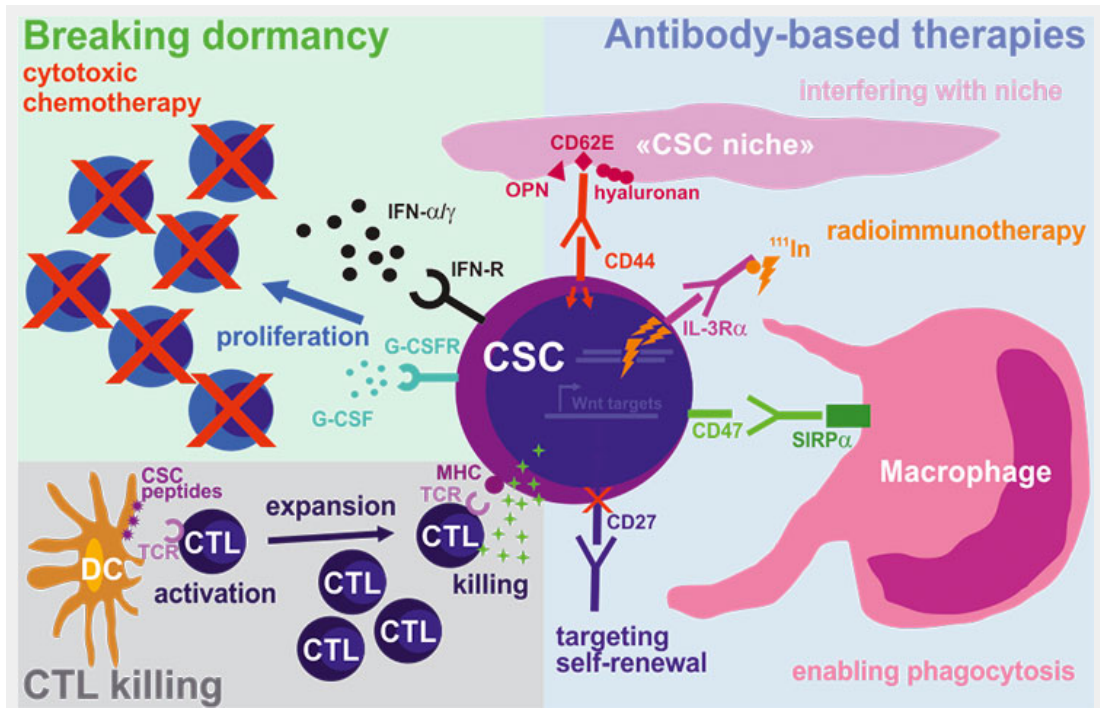
Figure 3 Targeting cancer stem cells (CSCs) using immunotherapy. As compared to the bulk of tumour cells, CSCs may also be targeted using antibody- based therapies by blocking pathways important for homing and engraftment (CD44), self-renewal (CD27), protection against phagocytosis (CD47) and by delivering radioactive compounds (IL-3Rα). In addition, strongly activated and expanded cytotoxic CD8+ T cells (CTLs) specific for CSC antigens are promising candidates for a potent and long-lasting elimination of CSCs. Finally, forcing CSCs into the cell-cycle by breaking their dormancy using proliferation-activating molecules, followed by conventional cytotoxic chemotherapy, may represent an attractive two-step strategy to eradicate